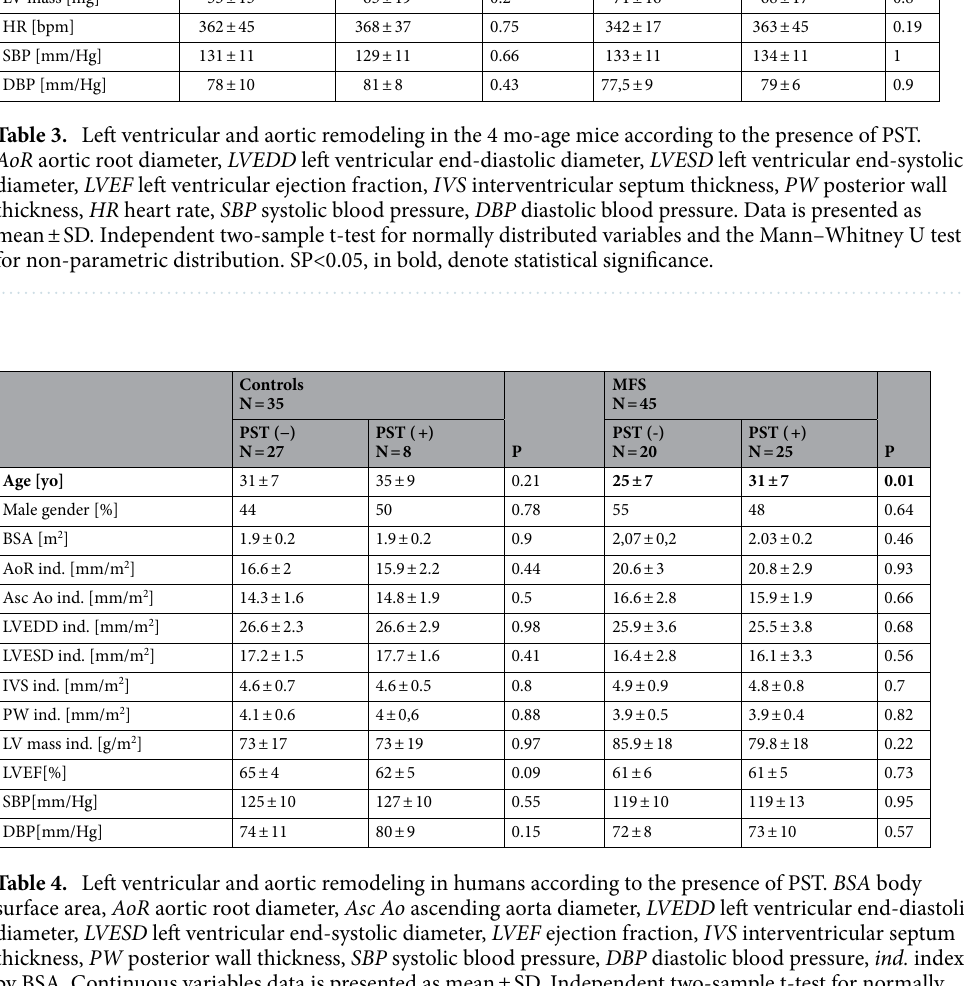
Table 4. Left ventricular and aortic remodeling in humans according to the presence of PST. BSA body surface area, AoR aortic root diameter, Asc Ao ascending aorta diameter, LVEDD left ventricular end-diastolic diameter, LVESD left ventricular end-systolic diameter, LVEF ejection fraction, IVS interventricular septum thickness, PW posterior wall thickness, SBP systolic blood pressure, DBP diastolic blood pressure, ind. indexed by BSA. Continuous variables data is presented as mean ± SD. Independent two-sample t-test for normally distributed continuous variables and the Mann–Whitney U test for non-parametric distribution. Categorical variable (male gender) is presented as percentage (%) and compared using χ 2 test. P<0.05, in bold, denote statistical significance.